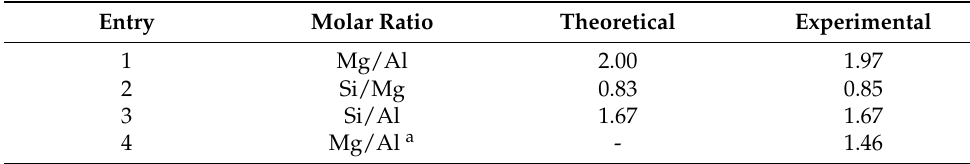
Table 1. Theoretical and experimental element ratios for the catalyst (SiO 2 @HT) as determined by ICP-MS. Entry Molar Ratio Theoretical Experimental 1 Mg/Al